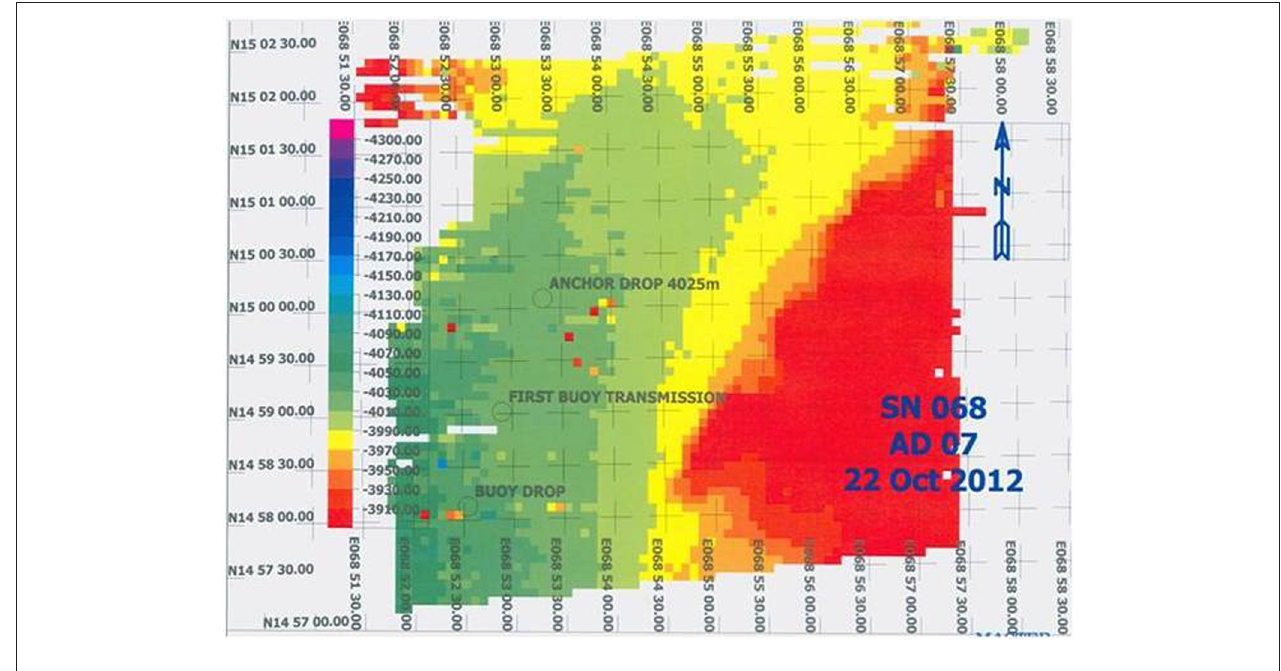
FIGURE 10 | Sea floor bathymetry.